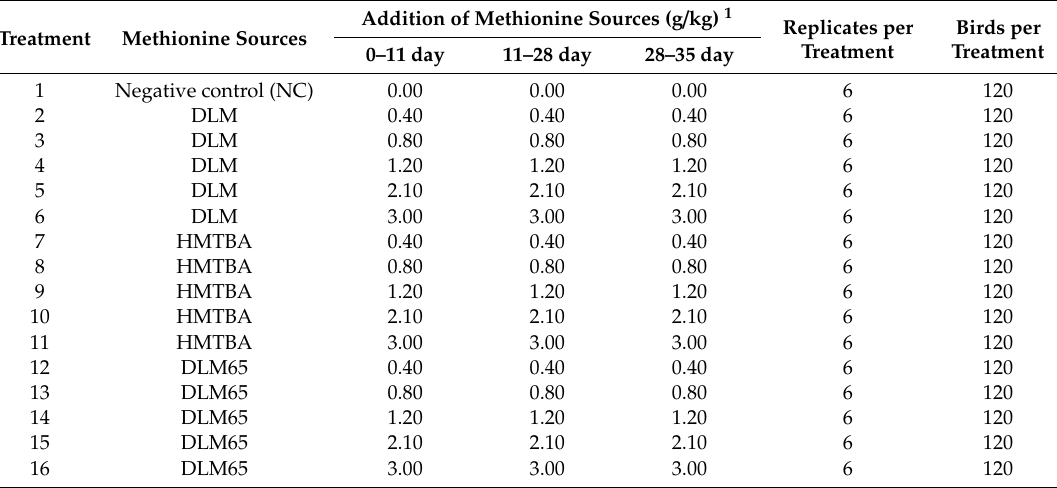
Table 2. Experimental design and supplementation levels of DL-methionine (DLM), DL-2-hydroxy -4-methylthio butanoic acid (HMTBA), and to 65% purity diluted DLM (DLM65). Addition of Methionine Sources (g / kg) 1 Replicates per Birds Treatment Methionine Sources Treatment